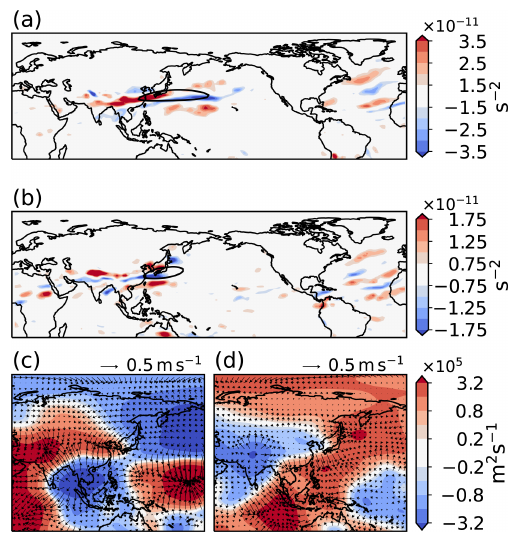
Figure 5. Spatial patterns of MEM anomalies in (a, b) Rossby wave source and (c, d) velocity potential (shades) with divergent flow (ar- rows) at 250hPa during JF (a, c) and MAM 2020 (b, d) . Note that the colour bar scale in (b) is halved in comparison to (a) . Black ellipses in (a, b) indicate the East Asian jet core, where values of the baseline 250hPa zonal wind are greater than 60ms − 1 in JF and 40ms − 1 in